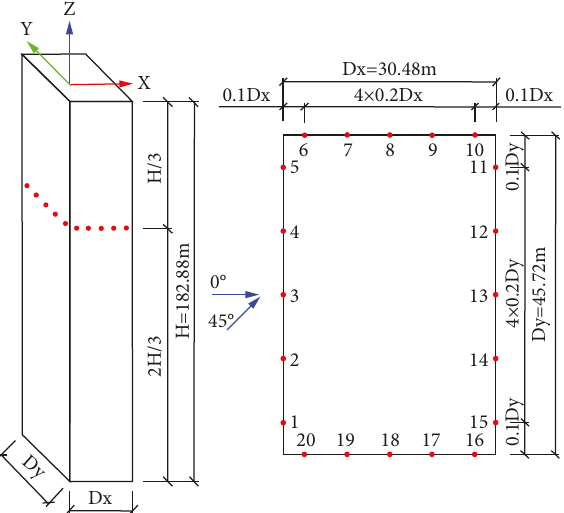
Figure 2: Geometric dimensions of CAARC standard mould and layout of pressure measuring points.